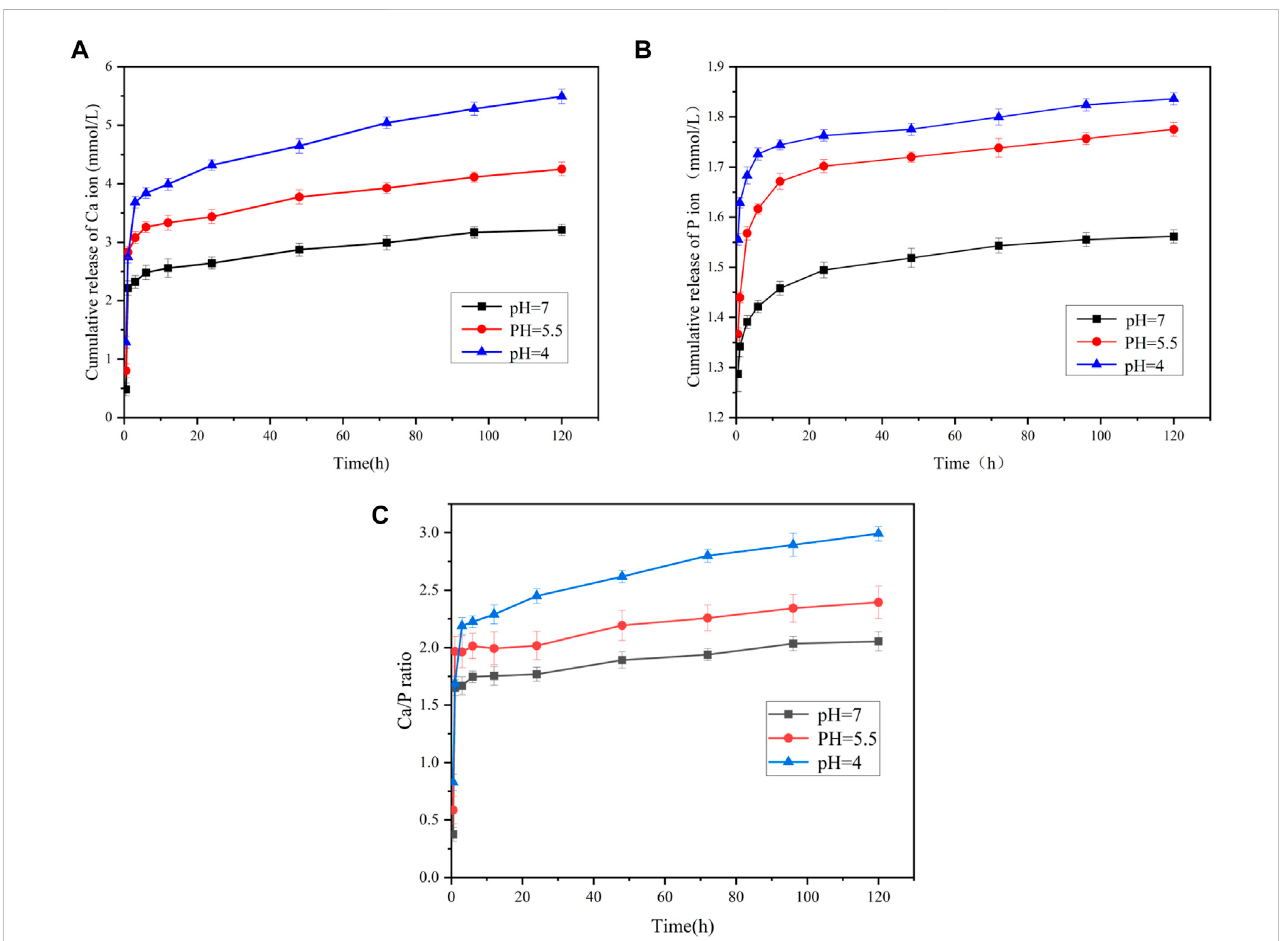
FIGURE 3 The ion release of the PAA-ACP@aMBG by ICP-OES. (A) Calcium ion release from PAA-ACP@aMBG. (B) Phosphorus ion release from PAA-ACP@aMBG under different pH conditions. (C) Ratio of the release of calcium and phosphorus ion from PAA-ACP@aMBG.